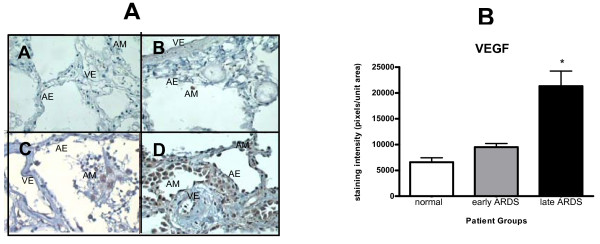
A) Immunocytochemistry of human whole lung tissue (× 40) showing (A) isotypic control (from later ARDS), (B) normal controls, (C) early ARDS, (D) later ARDS (magnification × 40). Immunostaining shows positive VEGF expression in alveolar epithelium (AE), alveolar macrophages (AM) and (to a lesser extent) vascular endothelium (VE). Significant increase in staining noted in ARDS, especially later ARDS. Staining was assessed semiquantitatively using Histometrix software analysis. B) Histometric analysis of human VEGF in healthy human lung, early and later ARDS. *P < 0.001 in later ARDS versus early ARDS and normal, (ANOVA with post-hoc Bonferroni). Data are normal and plotted as mean and standard error.